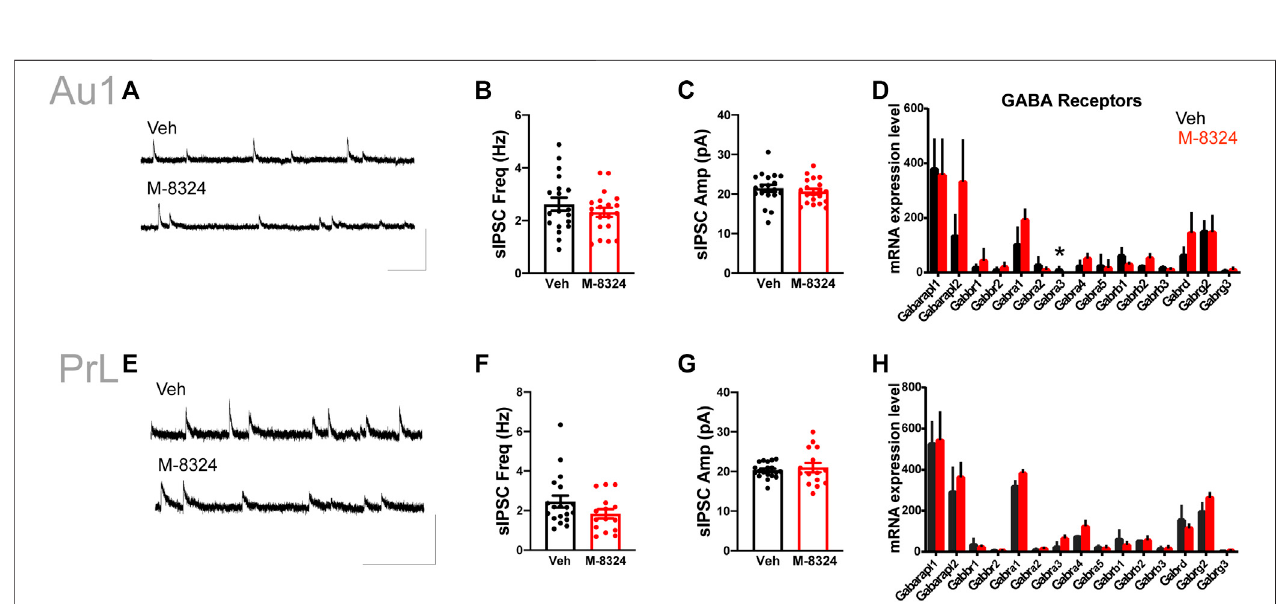
FIGURE 5 | Inhibitory synaptic transmission and expression of GABA receptors in PV-neurons after 7-days M-8324 treatment in Au1 and PrL-PFC. (A) RepresentativetracesofsIPSCinPV-neuronsinVehandM-8324groupsinAu1.Scalebars,50 pA/500 ms. (B) FrequencyofsIPSCwasnotdifferentbetweenVehand M-8324 groups in Au1. (C) Amplitude of sIPSC was not different between Veh and M-8324 groups in Au1. (E) Representative traces of sIPSC from PV-neurons in Veh andM-8324groupsinPrL-PFC.Scalebars,50 pA/500 ms. (F) FrequencyofsIPSCwasnotdifferentbetweenVehandM-8324groupsinPrL-PFC. (G) Amplitude ofsIPSCwasnotdifferentbetweenVehandM-8324groupsinPrL-PFC. (D,H) ExpressionsofGABAreceptor subunitsinPV-neuronsidenti fi edinAu1 (D) andPrL-PFC (H) by RNA-seq. N (cid:2) 18 cells/3 mice for both groups in Au1, N (cid:2) 19 cells/3 mice for Veh and N (cid:2) 15 cells/3 mice for M-8324 group in PrL-PFC. * p < 0.05.